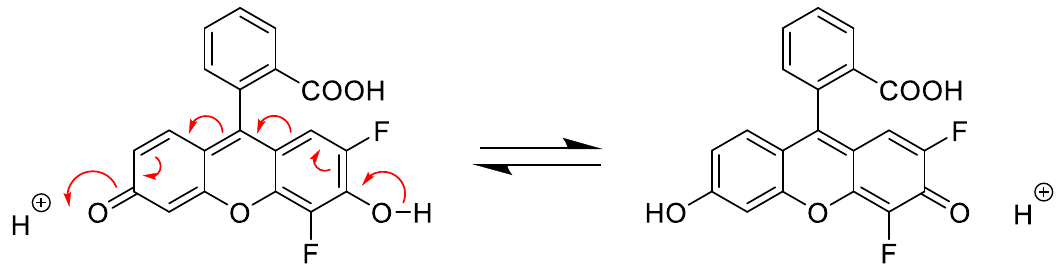
Figure 3. Tautomerization that shows the effective equivalence of the 2′,4′- and 5′,7′-